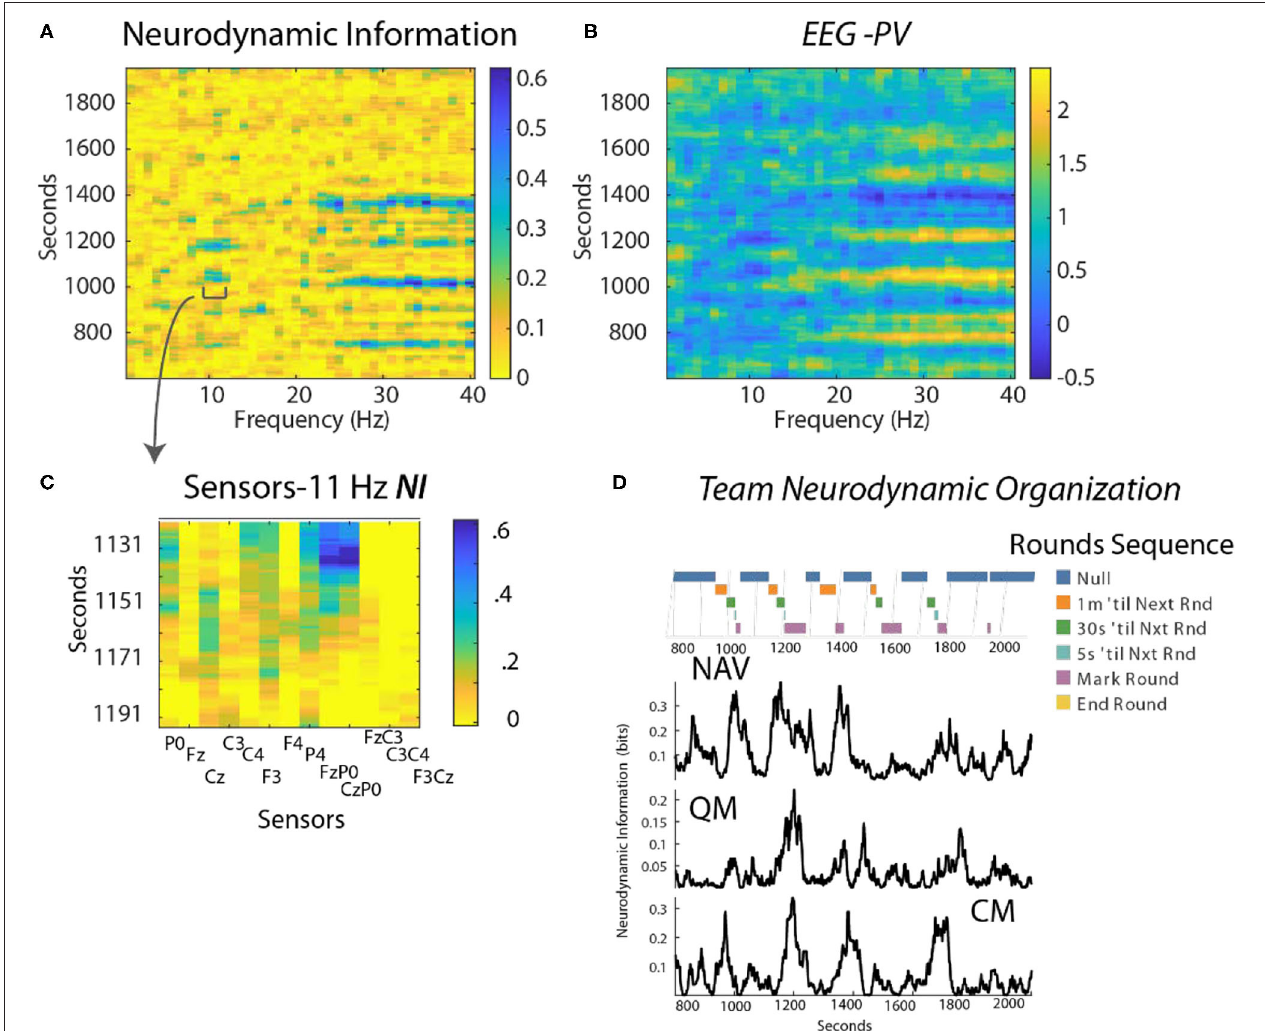
FIGURE 6 | (A) Time x Frequency x NI plot. The color bar indicates the bits of NI . (B) Time x Frequency x EEG-PV plot. The color bar shows the level of EEG-PV calculated from the − 1, 1, and 3 values; the average value for each frequency band was 1.0. (C) The data were modeled from the FzP0 dipole of the CM which had the highest NI levels of the channels. (D) The countdowns for the last minute of the five Rounds sequences are plotted vs. time. These figures plot the NI for the Navigator (NV mean NI = 0.23 bits, randomized = 0.01) Quartermaster (QM mean NI = 0.14 bits, randomized = 0.017) and the Contact Manager (CM, mean NI = 0.12 bits, randomized =